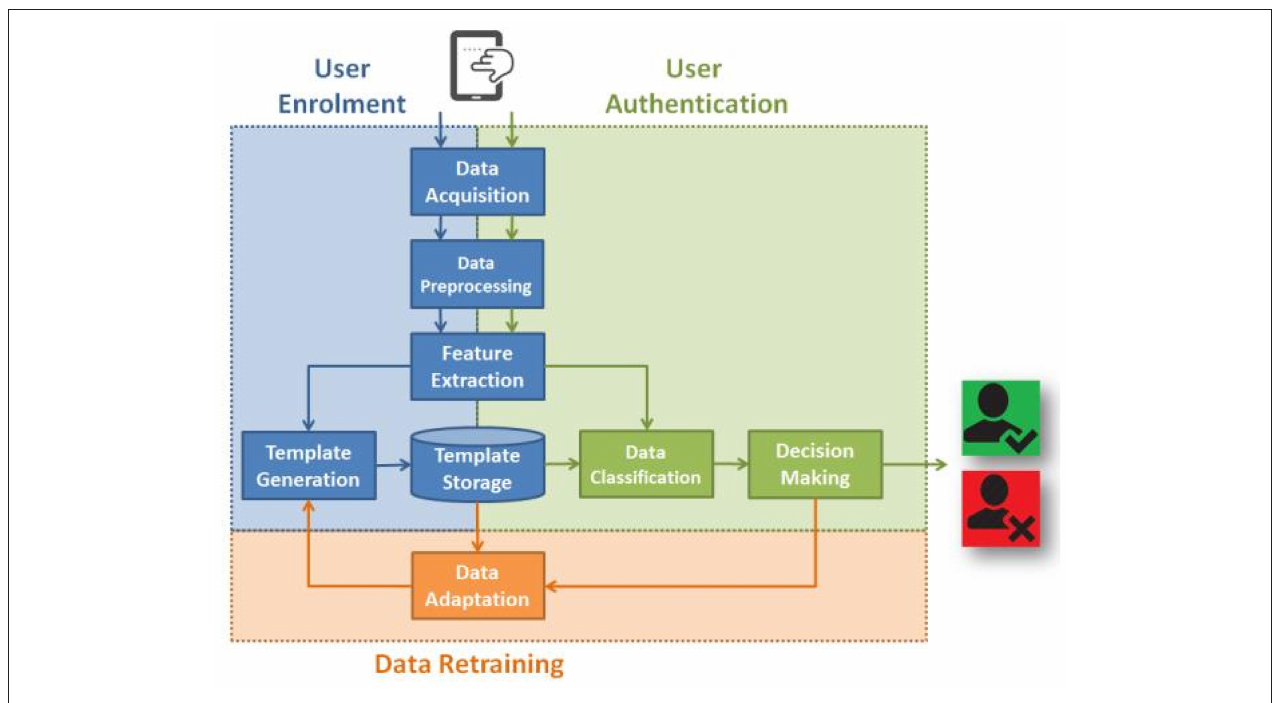
FIGURE 2 | A touchalytics framework for identifying a user [taken from Teh et al. (2016)]. (1) The data is acquired from finger swiping of a mobile device. (2) The data is pre-processed. (3) Features are extracted. (4) The data are classified. (5) A decision about whether the user is appropriate or not. The decision is fed back and the template for the user is adapted and stored. Taken from Teh et al.